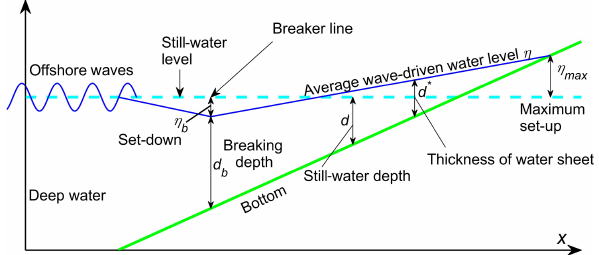
Figure 1. Scheme of the cross section of a coastal area with wave set-up. The sign of η is positive if the average wave-driven water level exceeds the still-water level and negative in the opposite case. The sign of d is positive in the area covered by still water and neg- ative in the otherwise dry section of the coast. The quantity d ∗ is